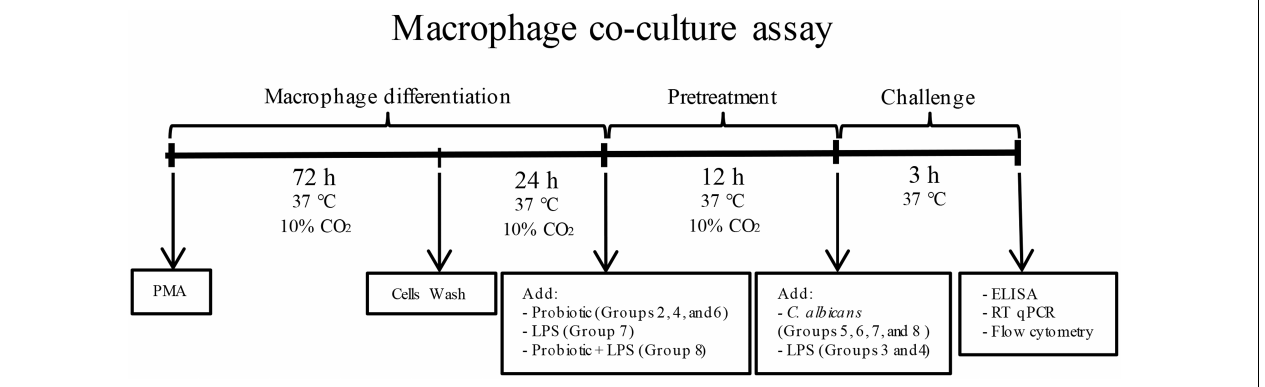
FIGURE 1 | Flowchart of macrophage co-culture assay. Macrophages were pretreated with probiotic lactobacilli alone (Groups 2, 4, and 6), LPS alone (Group 7) or both probiotic and LPS (Group 8). After 12 h of incubation (37 ◦ C, 10% CO 2 ), macrophages were challenged with Candida albicans (Groups 5, 6, 7, and 8) or LPS (Groups 3 and 4). Groups 3 and 5 had no pretreatment, Group 2 received no challenge, and Group 1 was the negative